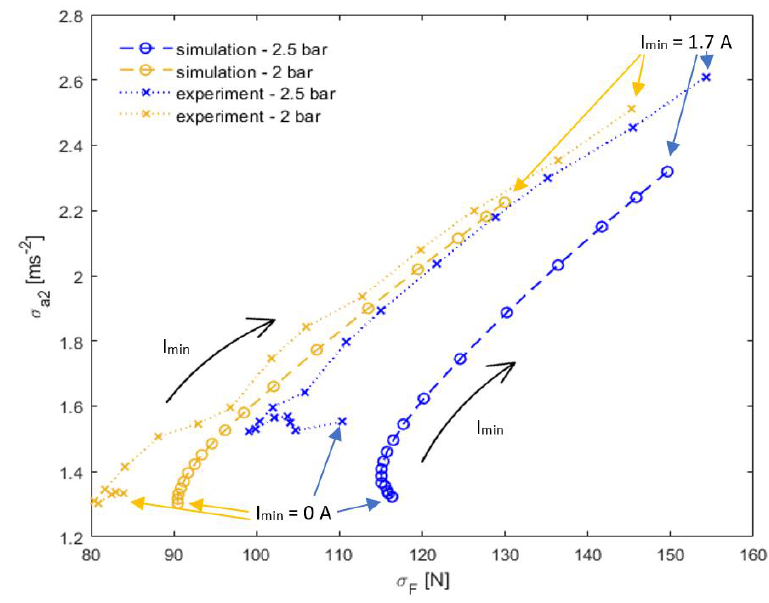
Figure 11. Tire pressure